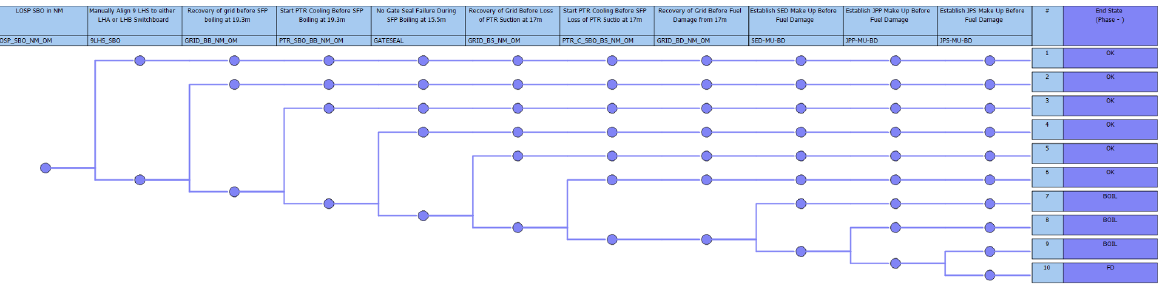
Figure 5. Event tree model of